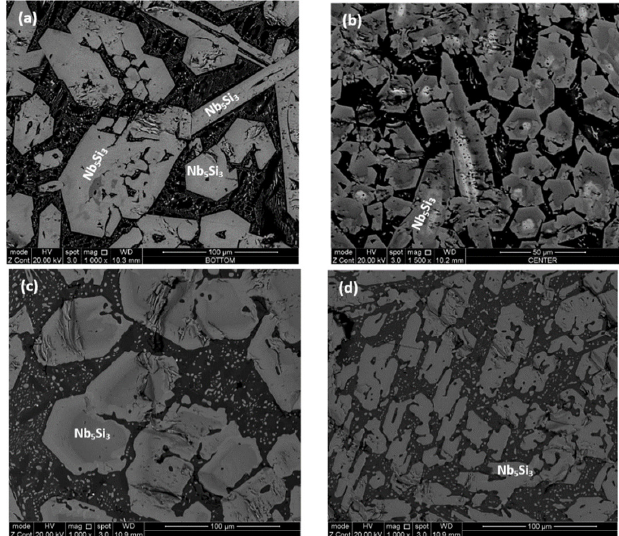
Figure 1. Scanning electron microscope (SEM) backscatter electron images of the alloy